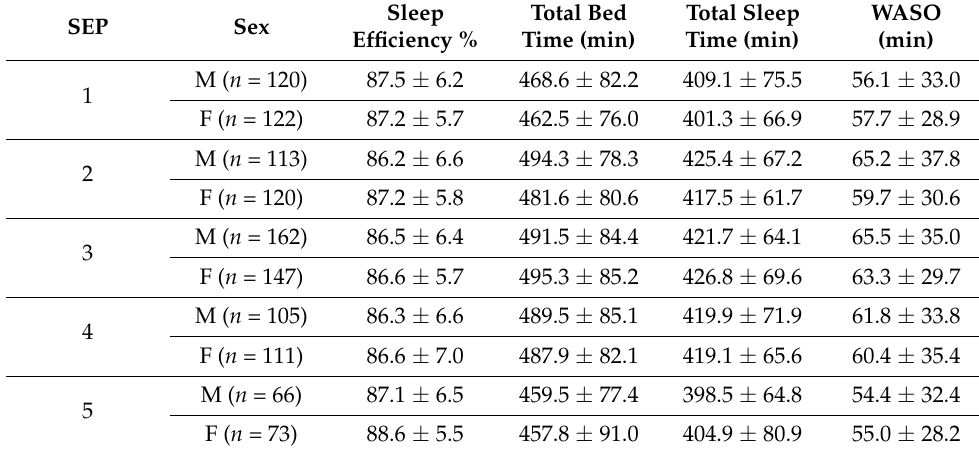
Table 3. Results of the daily sleep quality analysis in each SEP level divided by sex.